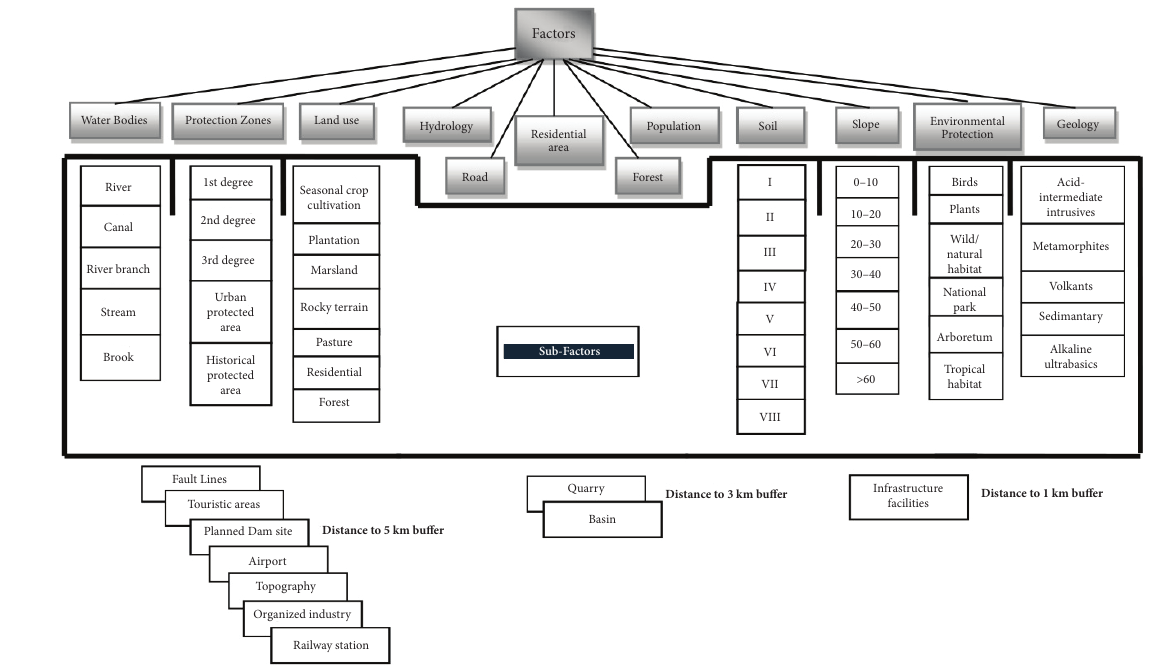
Figure 1. Factors and